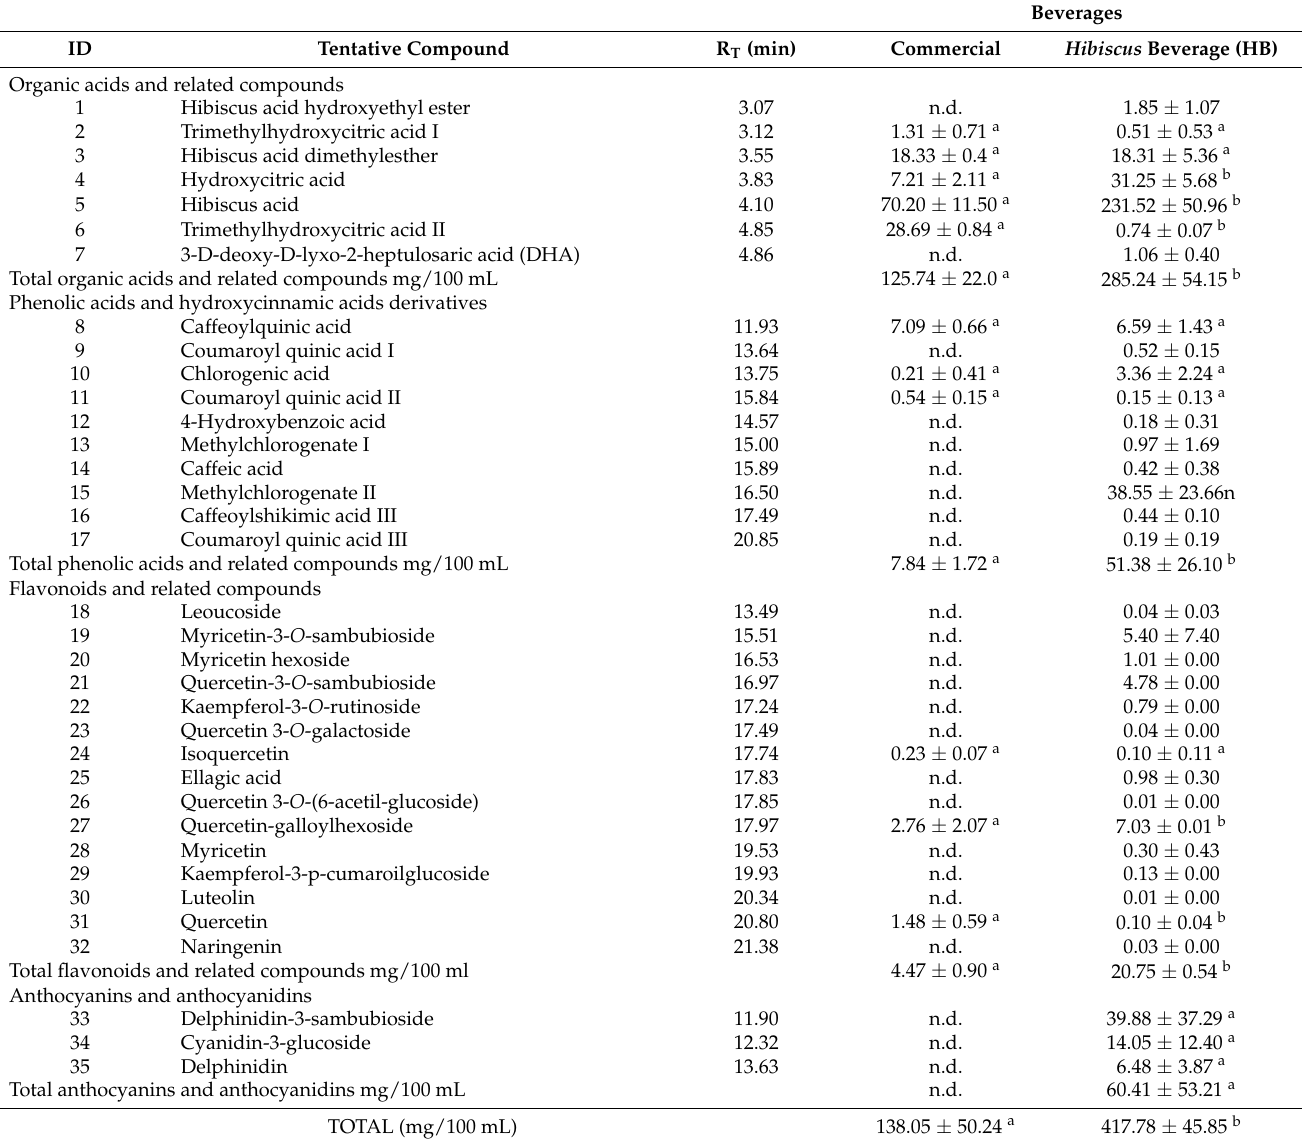
Values represent mean ± SD ( n = 3). Different lowercase letters in the same row indicate significant differences between beverages ( p < 0.05). n.d. = Not detected. Up to 18 flavonoids were quantified at the initial stage in the Hibiscus beverage, whereas in contrast, only three flavonoids were identified in the commercial beverage (Table 2). Glycosidic derivatives of flavonols (quercetin and kaempferol), aglycones (lu- teolin, quercetin, myricetin, and naringenin) were quantified in the beverage. These compounds are in concordance with the reported data by several studies which previously identified and quantified these compounds in Hibiscus and mint [4,5,10,21].